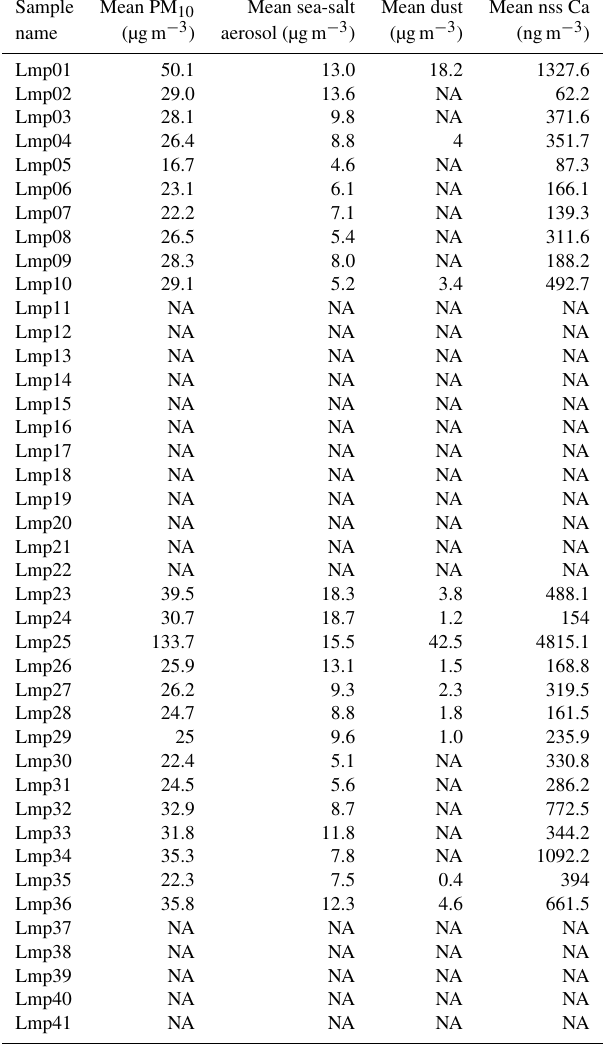
Table 4. The PM 10 , sea-salt aerosol, dust, and nss Ca mean values of the atmospheric total deposition.